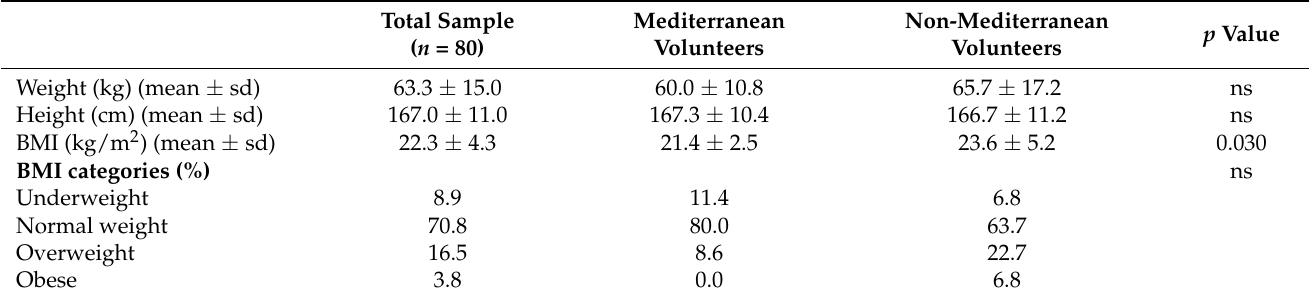
Table 7. Physical characteristics by geographical area of origin.